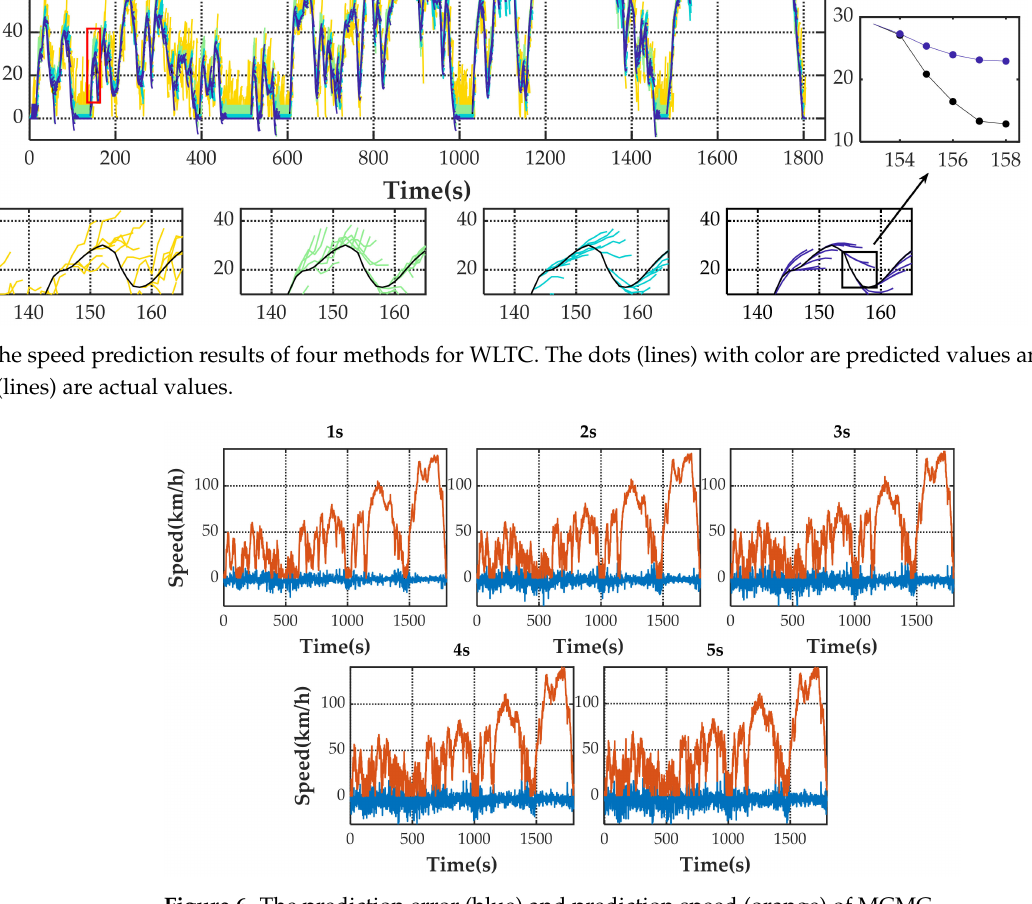
Figure 6. The prediction error (blue) and prediction speed (orange) of